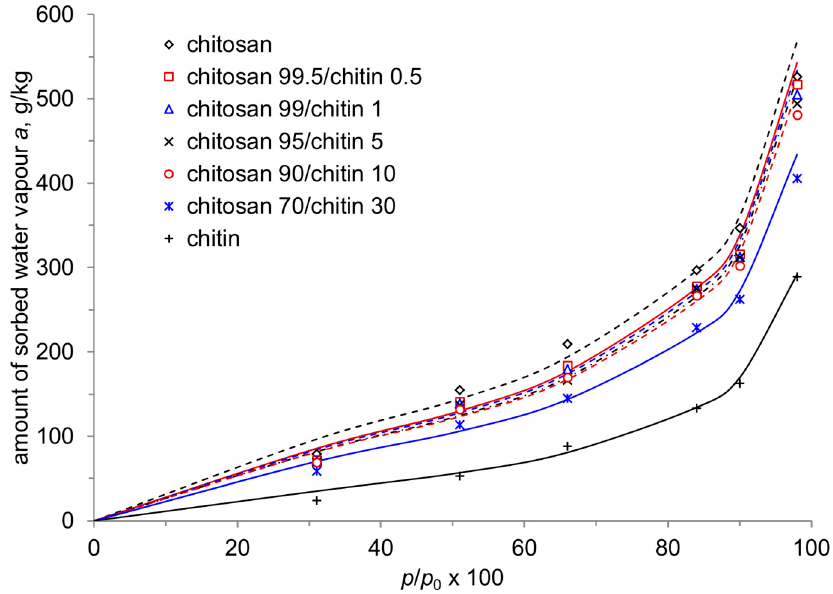
Figure 2. The sorption isotherms of water vapour by chitosan–chitin composite films. The symbols represent experimental data and the lines represent the sorption isotherms calculated by Equation